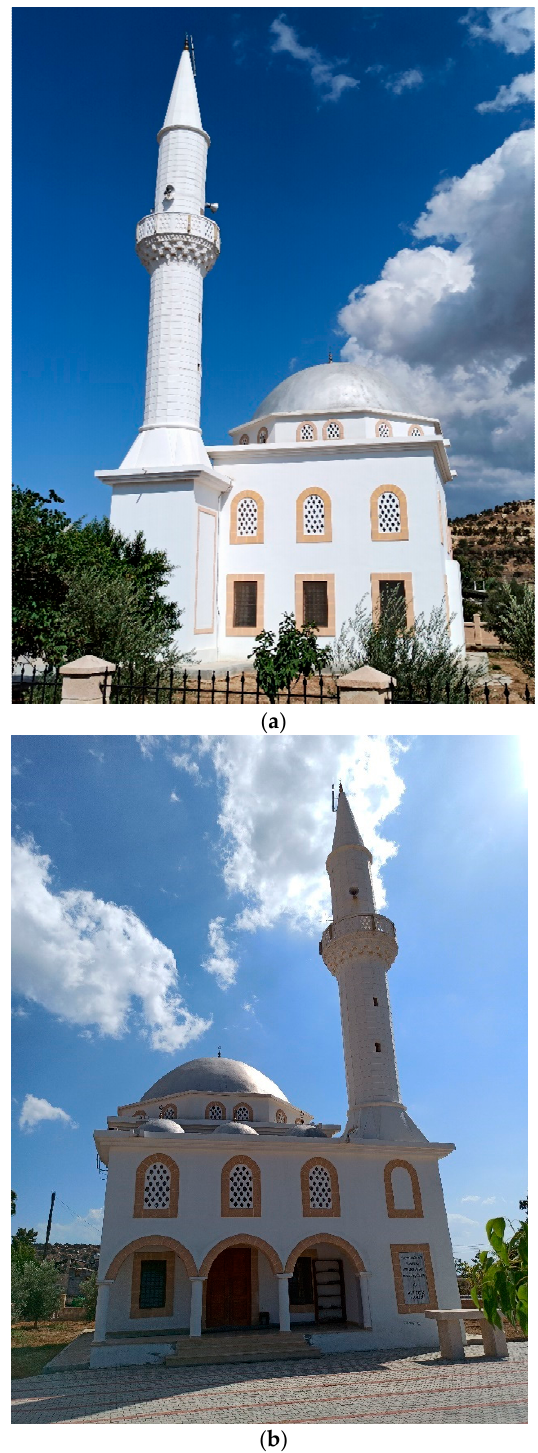
Figure 10. Kaleçik/Gastria, neo-Ottoman type A mosque, 2013: ( a ) exterior of the qibla wall on the right; ( b ) arcaded entrance portico (photo: authors).